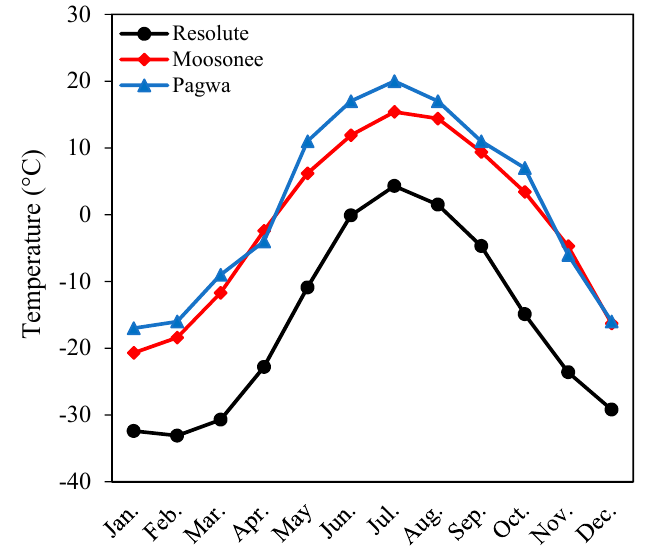
Figure 3. Average temperature for Resolute, Moosonee, and Pagwa [60].